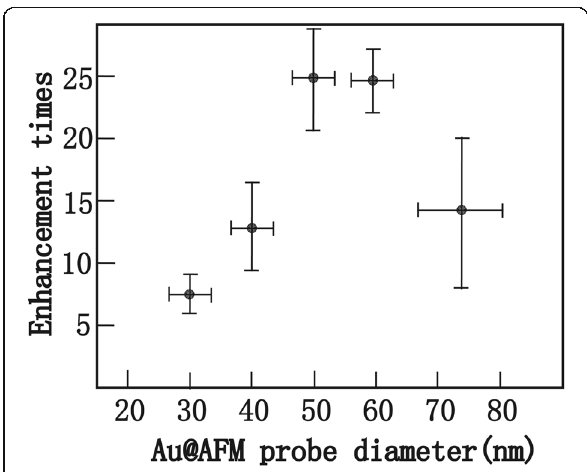
Fig. 4 Change of TERS enhancement with the increased diameter